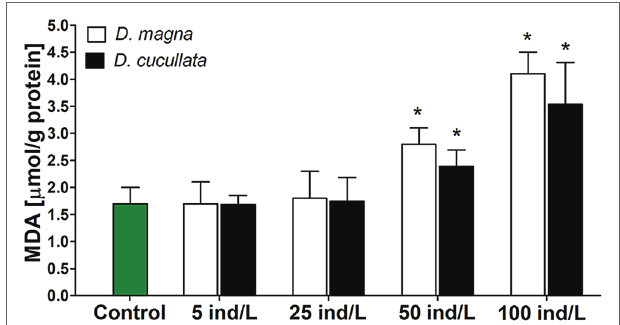
FIGURE 3 | The peroxidation of lipids measured by means of intracellular thiobarbituric acid reactive substance content (mean and SD), mainly represented by malondialdehyde (MDA) in M. aeruginosa exposed for 7 days to different concentrations of D. magna and D. cucullata ( n = 5). An asterisk indicates a significant difference with the control ( p < 0.05; Mann- Whitney U